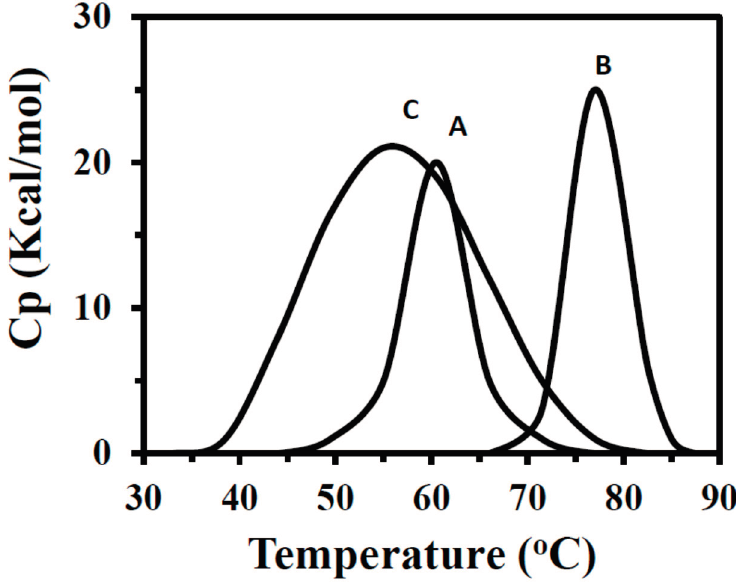
Figure 4. DSC profiles of free BLG (A), BLG-[ n -PrNH 2 -KIT-6] (B) and BLG-B-KIT-6